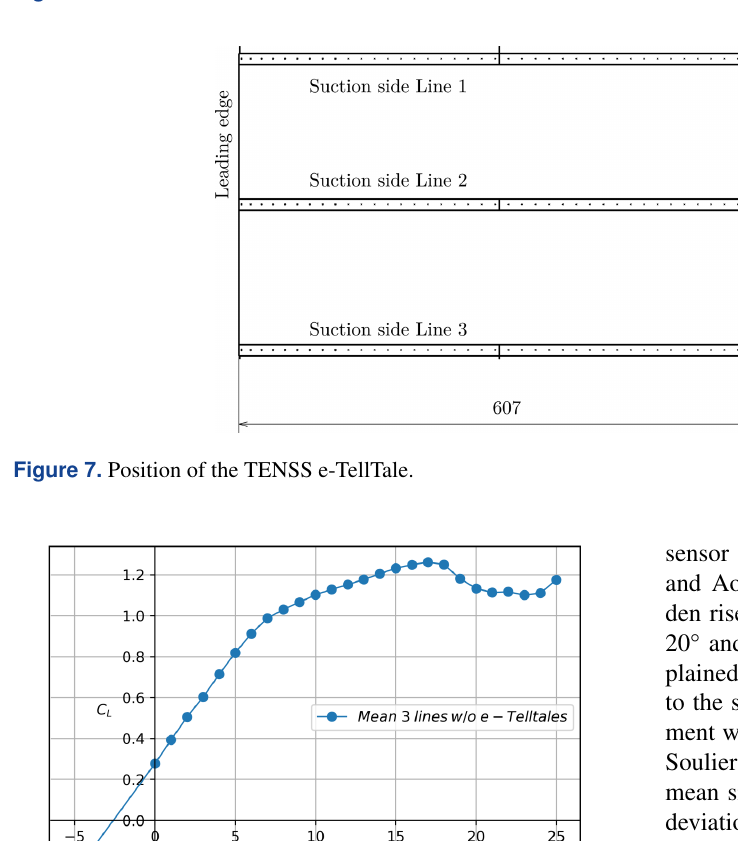
Figure 6. Positions of LENSL and TENSL e-TellTale sensors.